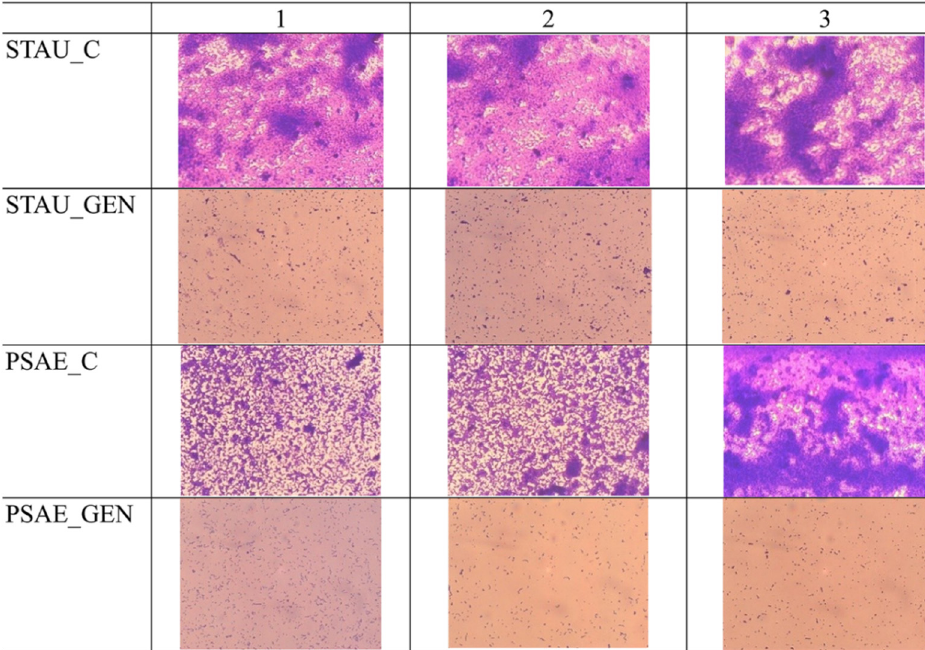
Figure 7. Eradication of biofilm of P. aeruginosa (PSAE_C) and S. aureus (STAU_C) by PCL substrate with SLP from myristyl alcohol was not visible but PCL substrate with myristyl alcohol and gentamicin (MA_GEN_1,5 group) (PSAE_GEN, STAU_GEN) showed sufficient bacteria eradication (scanned by inverse light microscope analysis), the samples were tested in triplicates and the results are shown in 3 columns.